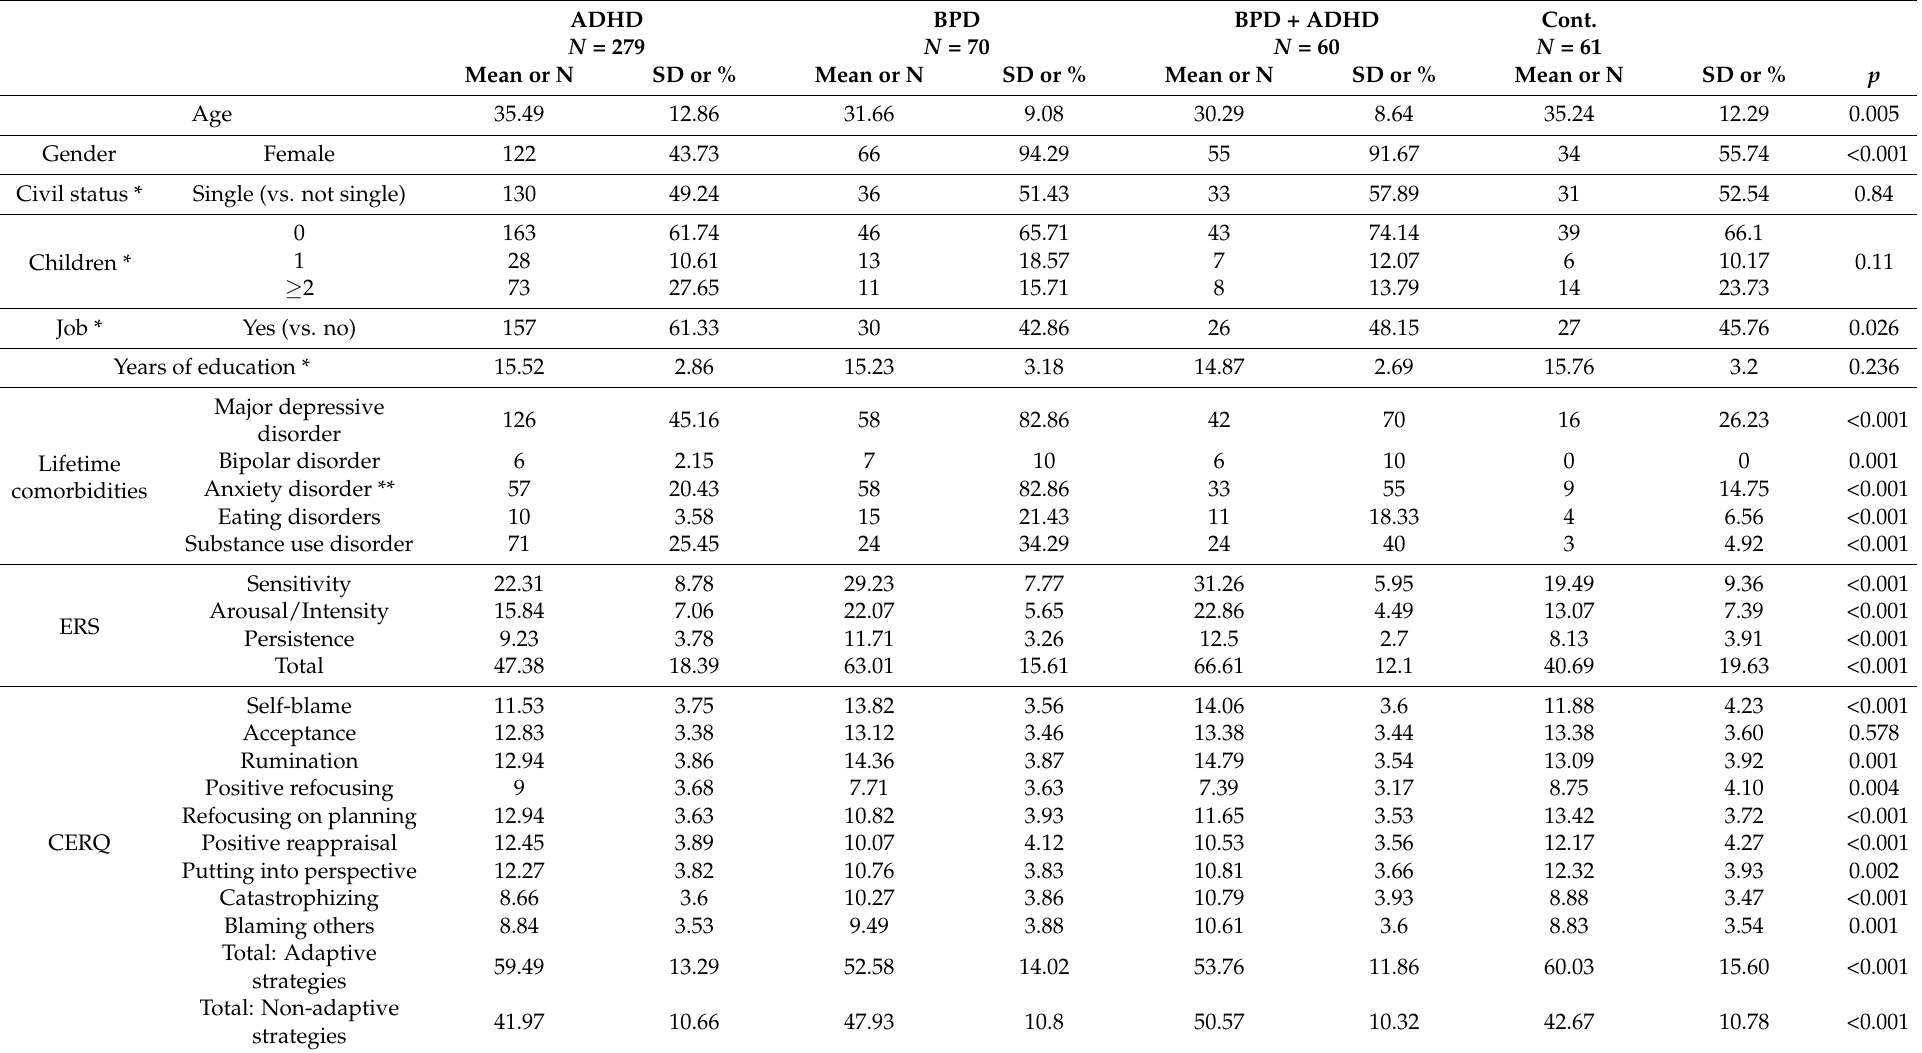
Table 1. Clinical and demographic characteristics of